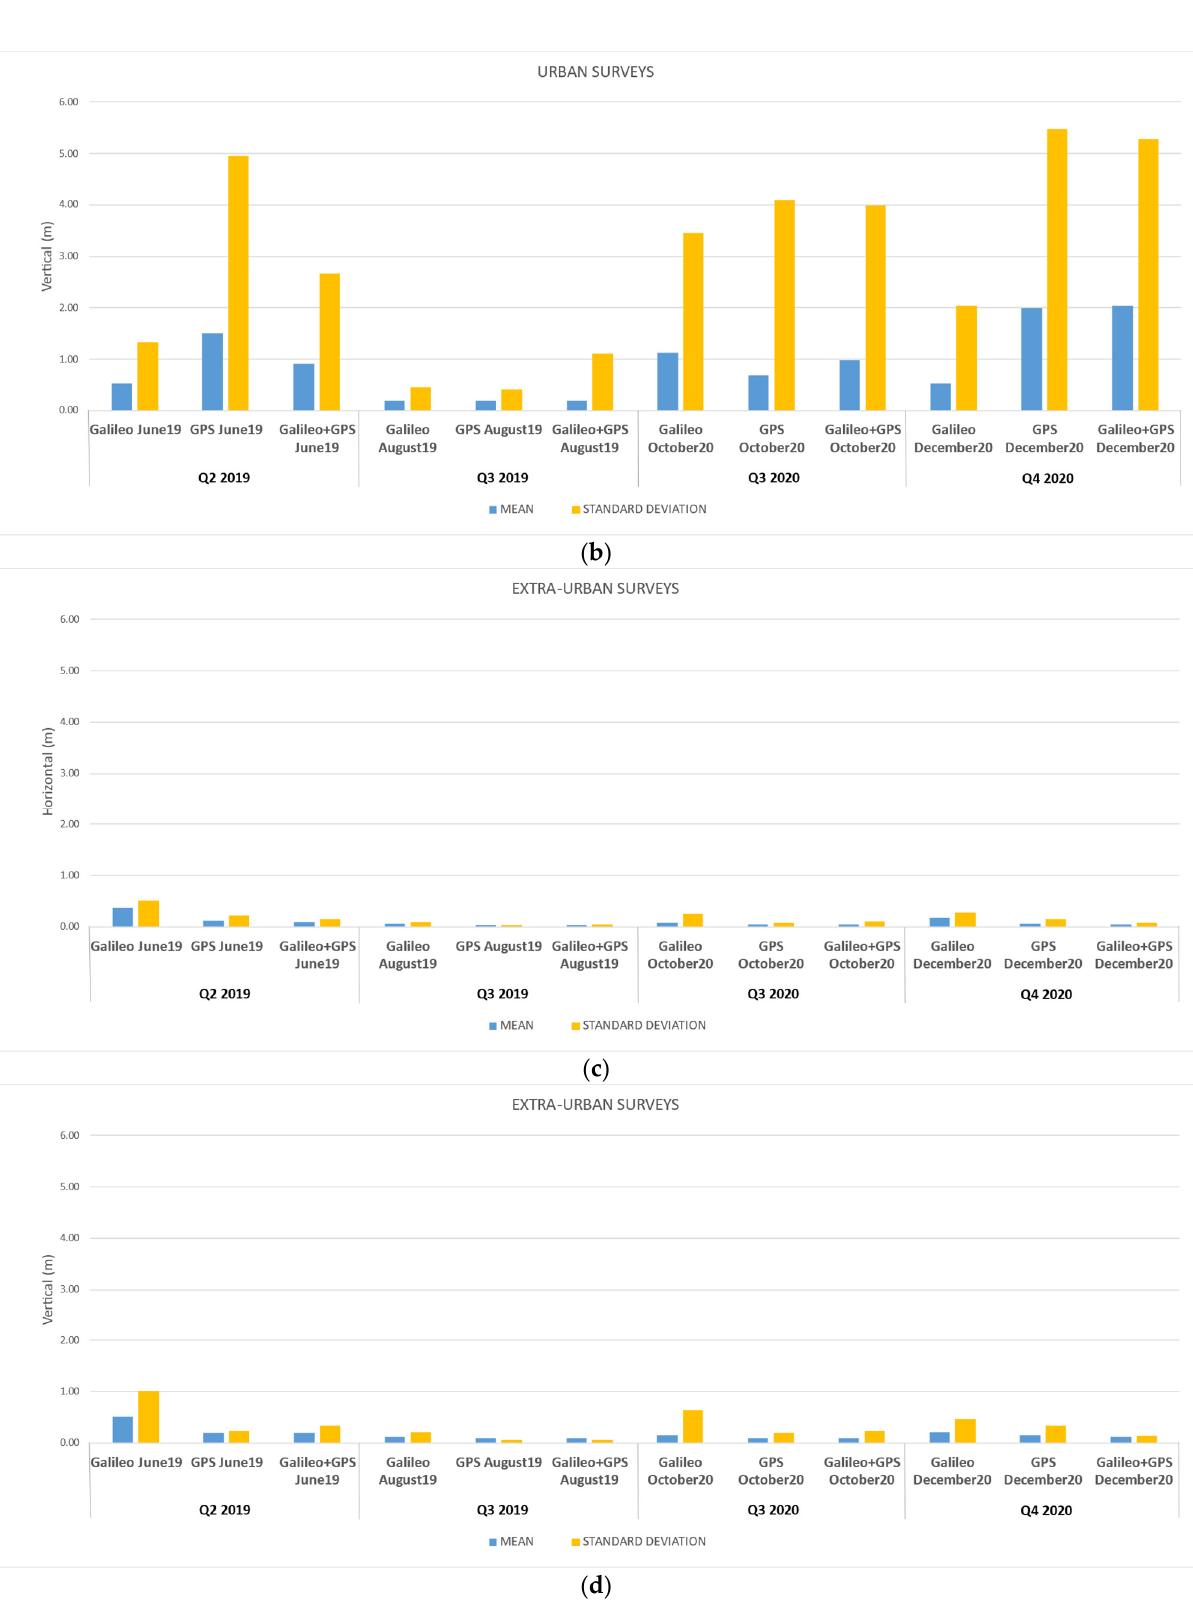
Figure 14. Horizontal and vertical mean values and standard deviations (in meters) for the different campaigns in terrestrial environments (urban and extra-urban) using GNSS/INS MMS as reference: ( a , b ) for urban, ( c , d ) for extra-urban surveys.